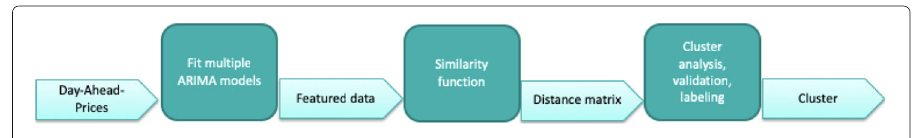
Fig. 1 Workflow of the